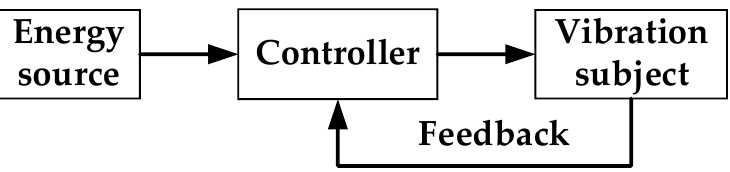
Figure 13. Self-excited oscillation feedback mechanism.